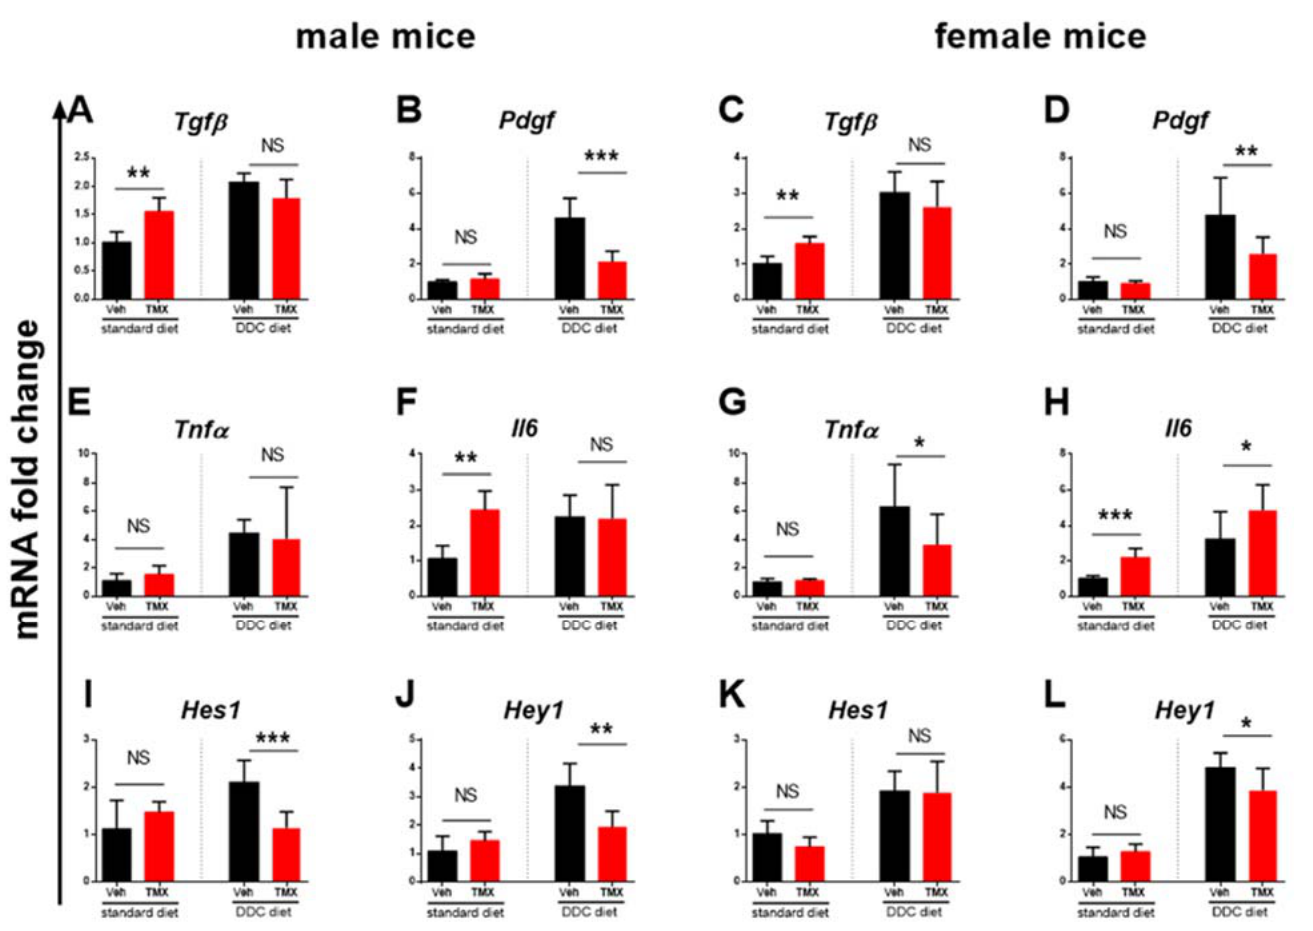
Figure 4. Expression of inflammatory and Notch-pathway related genes. Male or female mice were fed standard or DDC-supplemented diet as indicated, and treated with vehicle (black bars) or tamoxifen (red bars). Gene expression of Tgf β , Pdgf ( A – D ), Tnf α , Il6 ( E – H ), Hes1, and Hey1 ( I–L ) was determined in liver tissue using qPCR. Data represent mean + SD, Student’s t ‐ test was used for comparison between the groups, * p < 0.05, ** p < 0.01, *** p < 0.001, NS—nonsignificant. Tgf β —